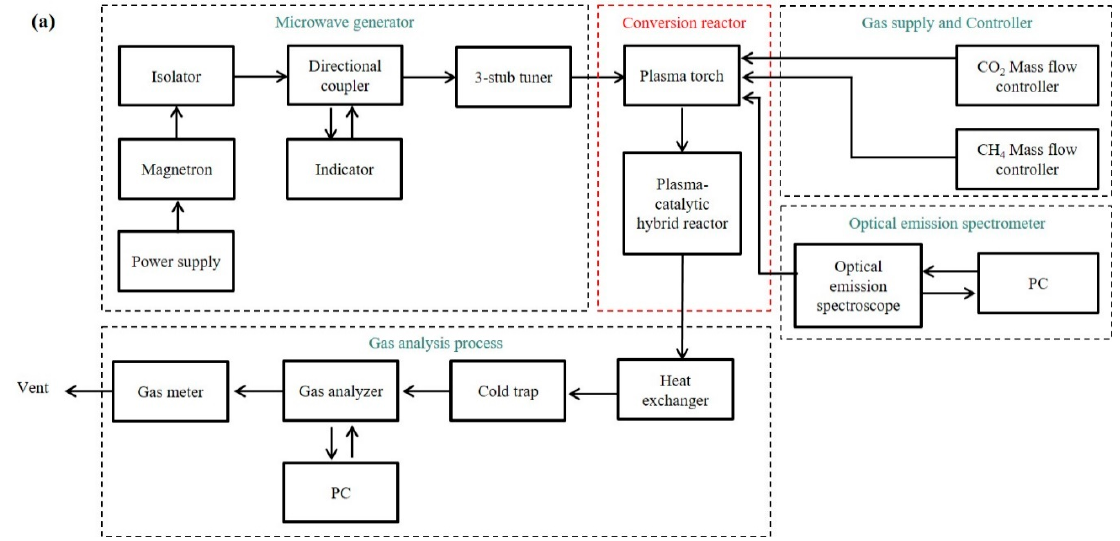
Figure 9. ( a ) Flow diagram and ( b ) schematic diagrams of the experimental setup of microwave 4 plasma-catalytic reactor used for syngas production.